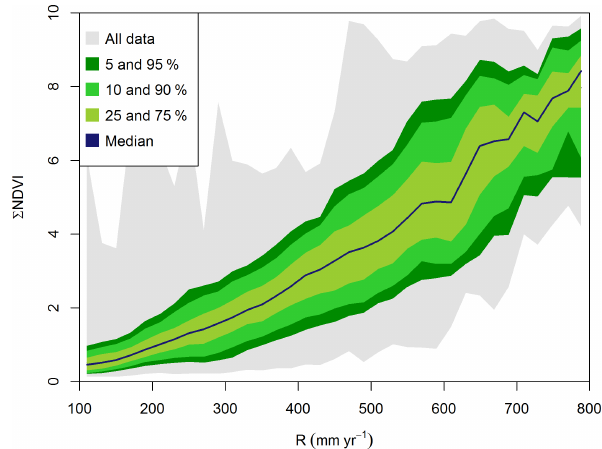
Figure 4. Growing season ANPP ( P NDVI) as a function of mean seasonal rainfall amount ( R ) plotted as quantiles for the Sahel– Sudanian zone (pixel averages for